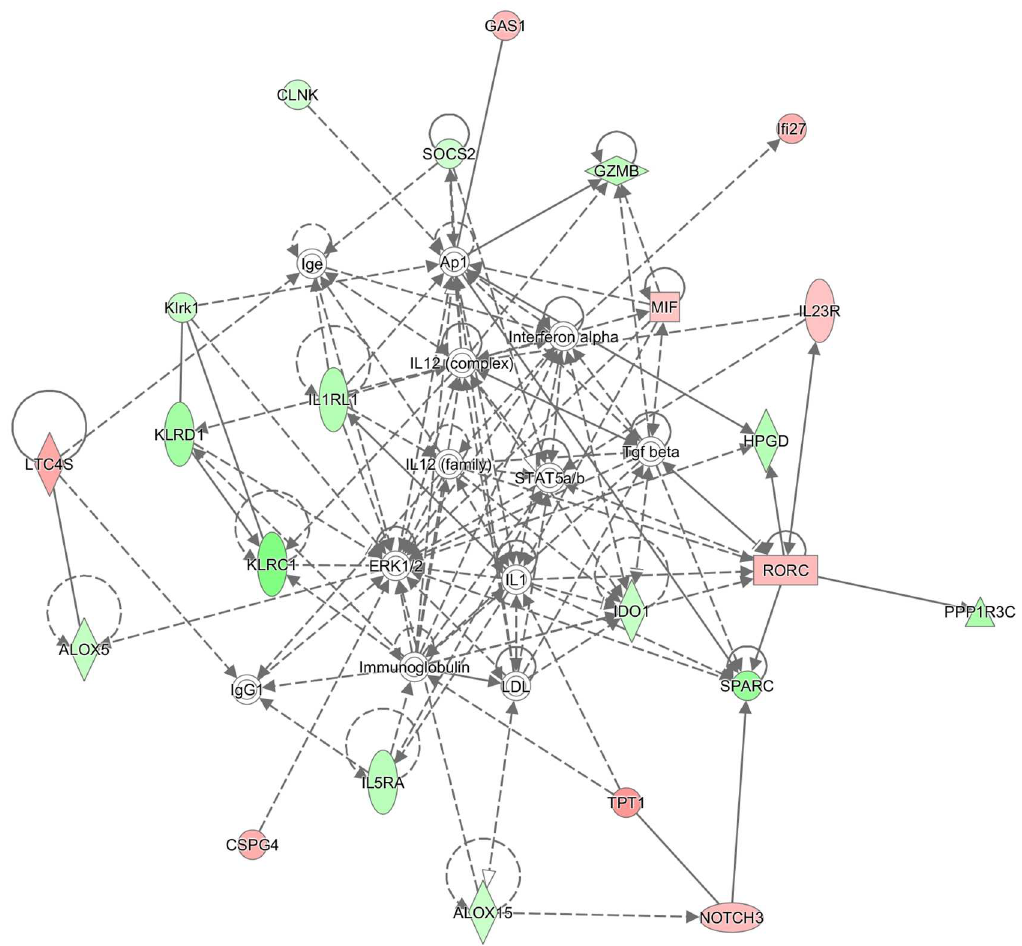
Fig 3. The most relevant network associated with DE genes of the PP vs NN comparison. Up-regulated(pink) and down-regulated (green) genes involvedin lipid metabolism, small molecules biochemistry and Inflammatory response functions. Different shapes indicate different function of gene products: squares for cytokines, horizontal rectanglesfor ligand-dependentnuclear receptor, vertical rectanglesfor G-protein coupled receptors, vertical rhombus for enzymes, horizontalrhombus for peptidase,triangles for phosphatase, inverted triangle for kinase, vertical ovals for transmembrane receptors, horizontalovals for transcription regulators, trapezius for transporters, doublecircles for complexes and circles for